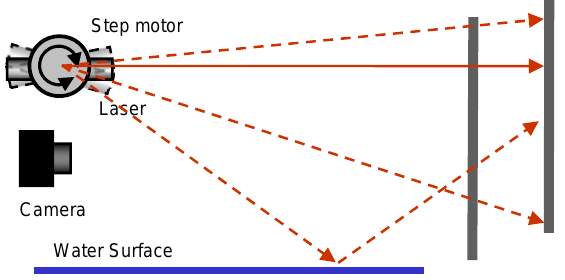
Figure 15: Data acquisition for calibration - direct and indirect projection at different rotation